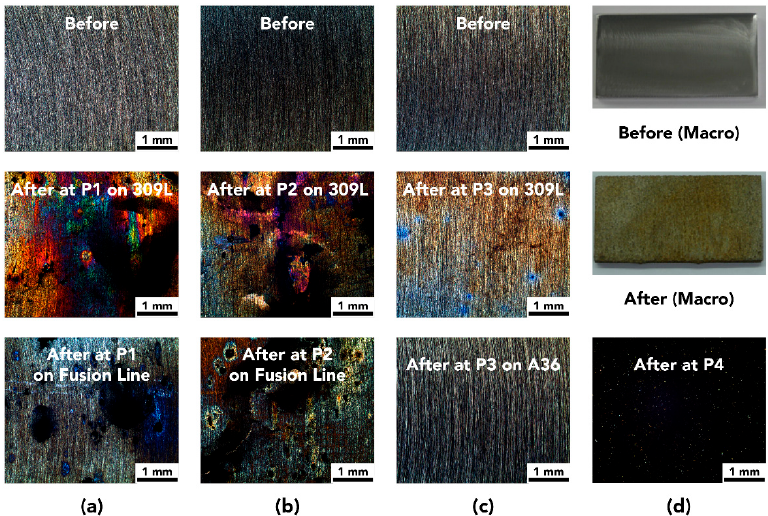
Figure 11. The pitting corrosion testing results: ( a ) Cladding layer over weldment (P1); ( b ) Cladding layer (P2); ( c ) Cladding-substrate layer (P3); ( d ) Substrate layer (P4). Note that all the images were magnified at 20 × except those stating “macro”.